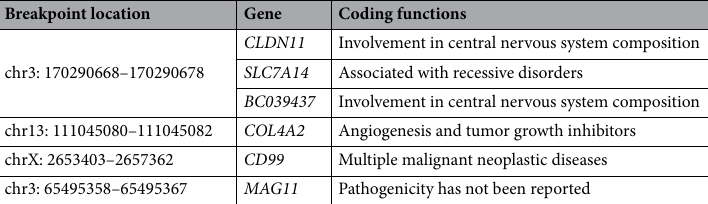
Table 1. Table of genes and functions disrupted by